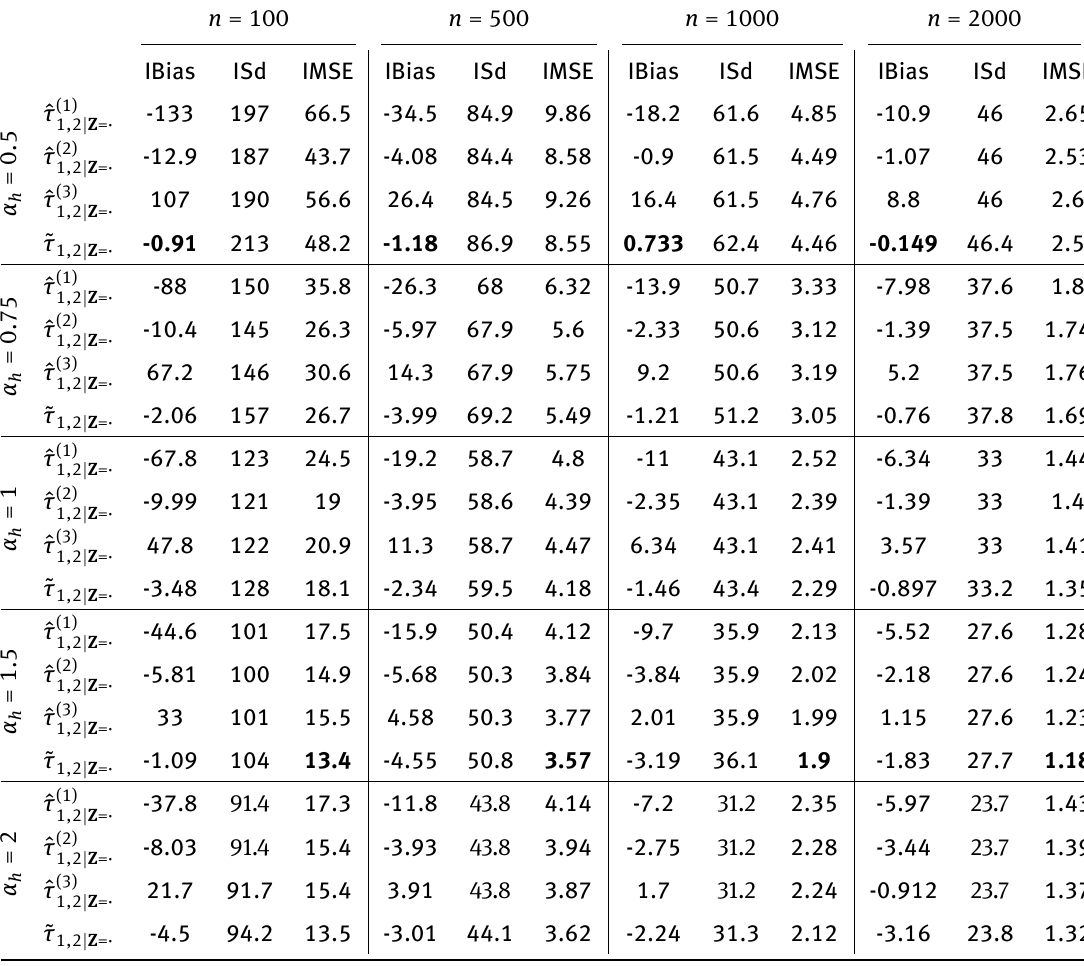
Table 1: Results of the simulation in Setting 1. All values have been multiplied by 1000. Bold values indicate optimal choices for the chosen measure of performance. These results are integrated measures of performance over the whole space Z ; the corresponding local measures of performance are displayed in Figures 1 and